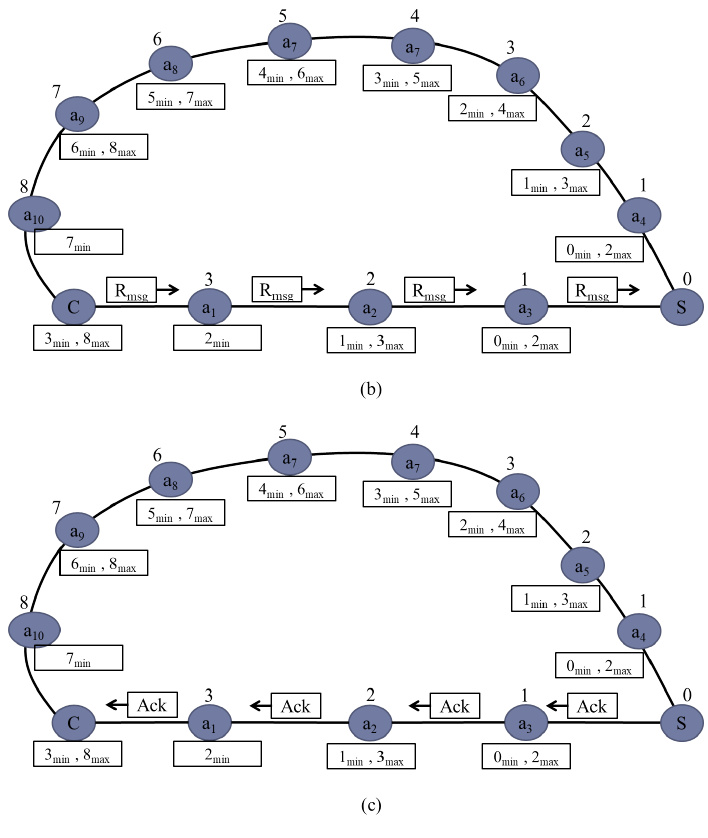
Figure 7. Sample network deployment